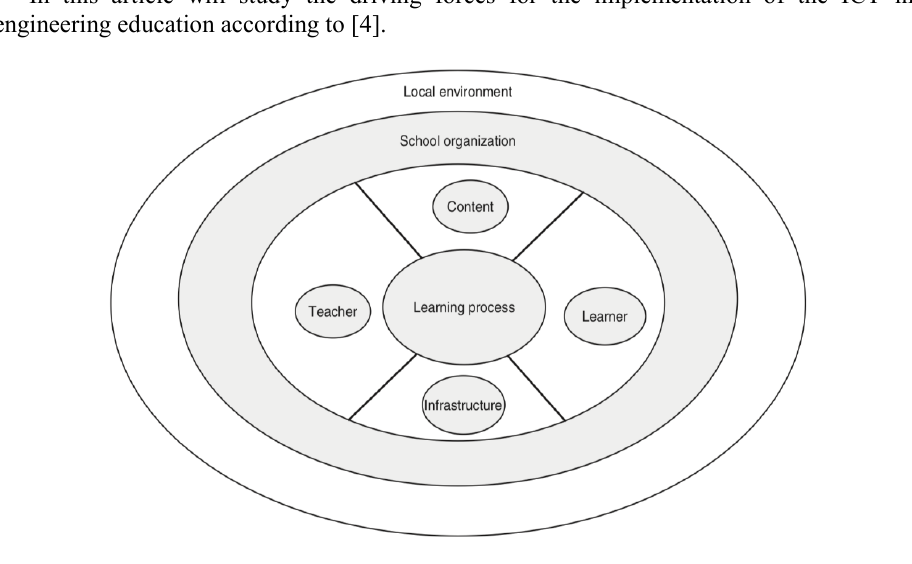
Fig. 1. Driving forces of ICT in the learning process